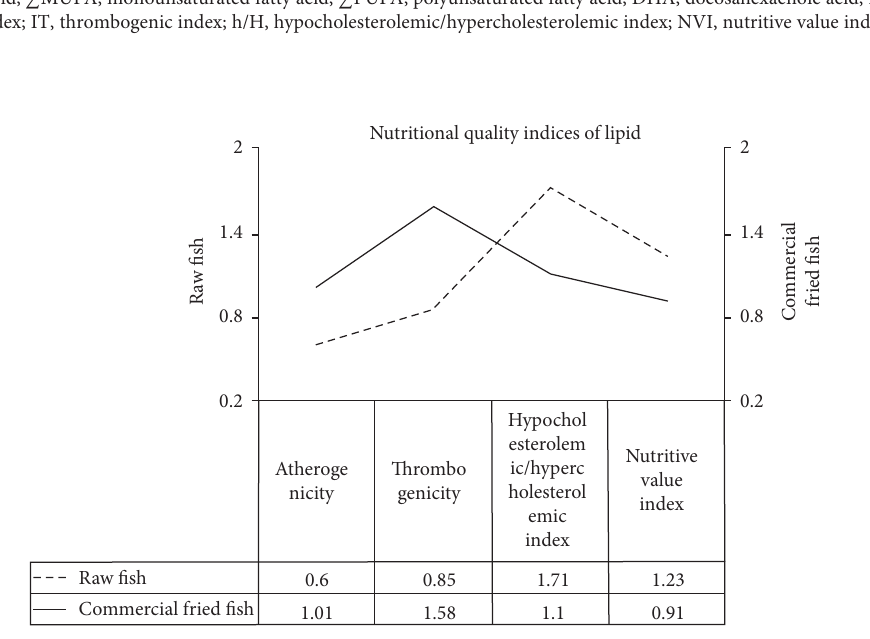
Figure 2. Peroxidizability index (PI) is another parameter to indicate the relationship between the fatty acid composition